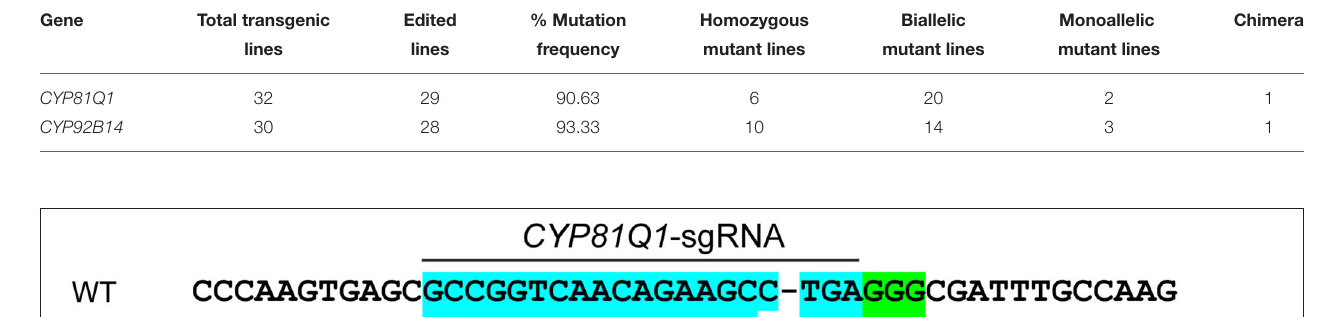
Frontiers in Plant Science |